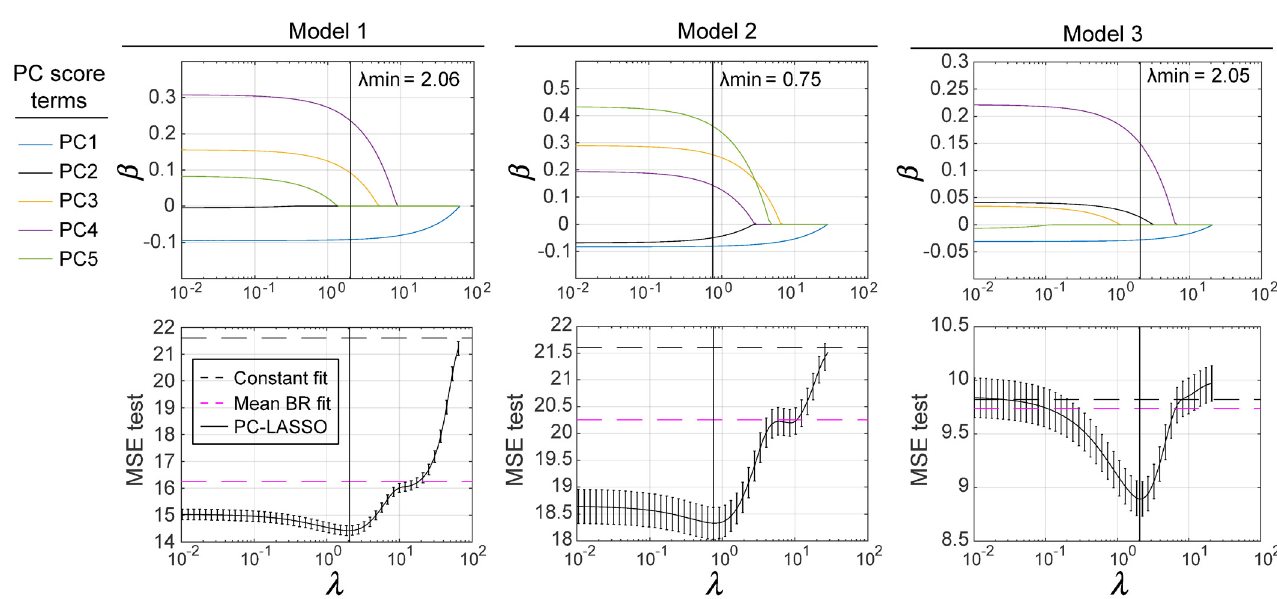
Fig 5. Trace plots of the coefficients β j and cross-validated MSE test for the best three PC-LASSO models. The coefficients β j were fitted using the entire data. For comparison, the MSE test produced by the mean BR and constant models are indicated by dashed horizontal lines. λ minimum in MSE test (indicated by vertical